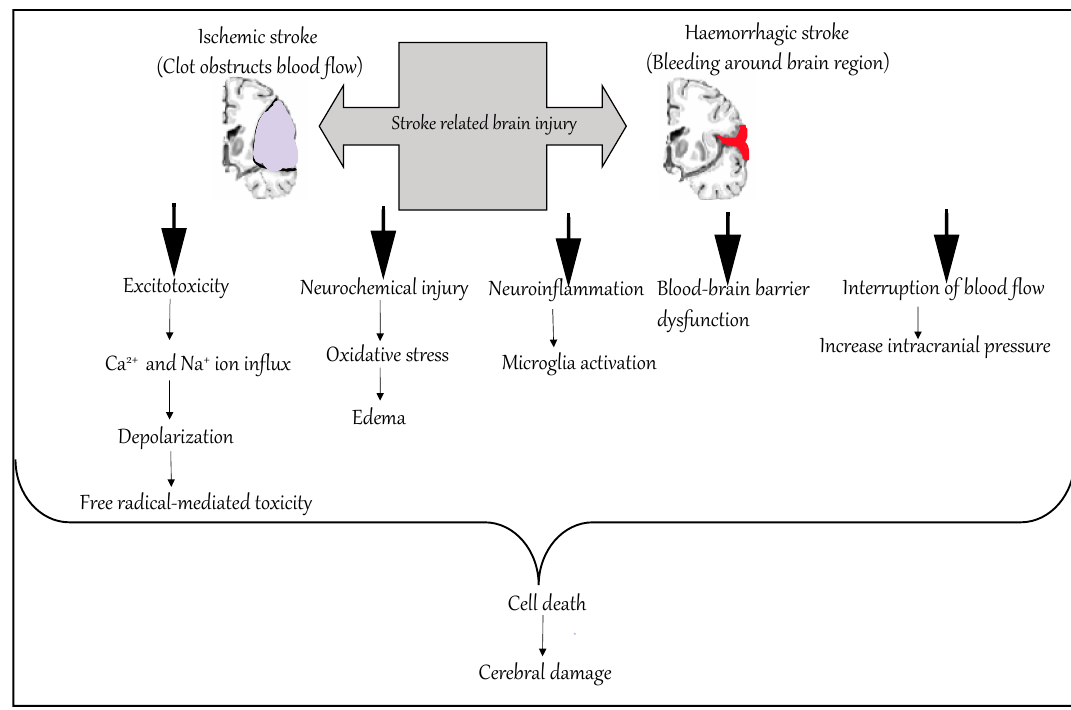
Figure 1. Molecular mechanism of stroke.